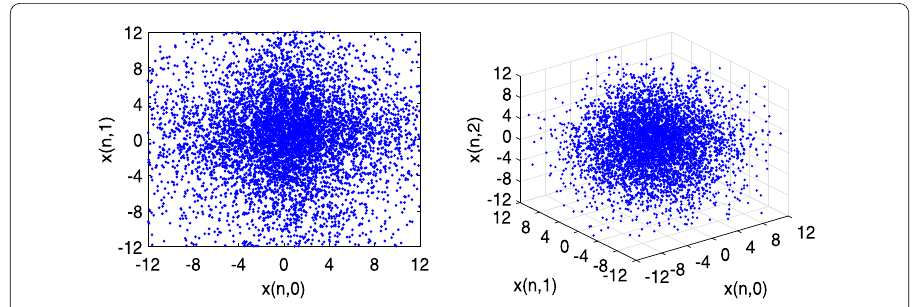
Figure 1 Simulations for system (2) with (6), where n = 0,1, ... ,10,000 and p = 0. In the 2-D graph, the initial values are taken as x (0,0) = 0.1 and x (0,1) = –0.1. The initial values are x (0,0) = 0.1, x (0,1) = –0.1, and x (0,2) = 0.1 in the 3-D graph